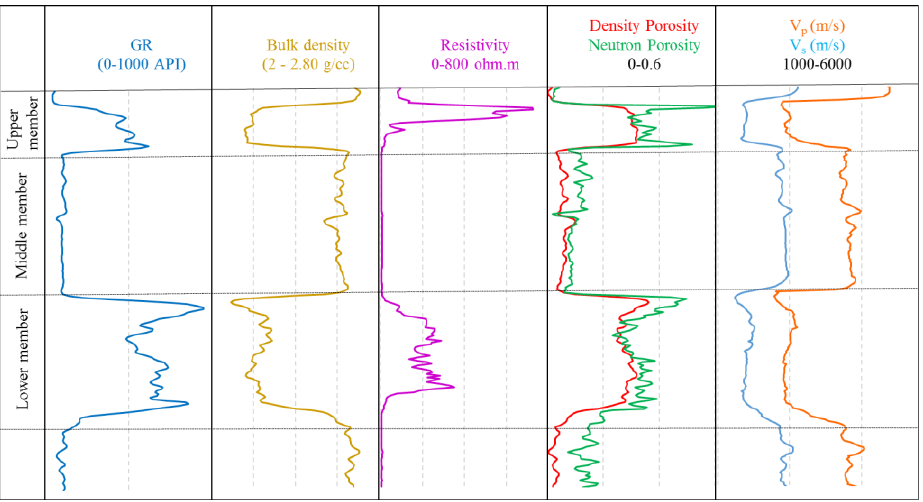
Figure 1. Well logs distinguishing the Upper, Middle, and Lower Bakken Formation [11].